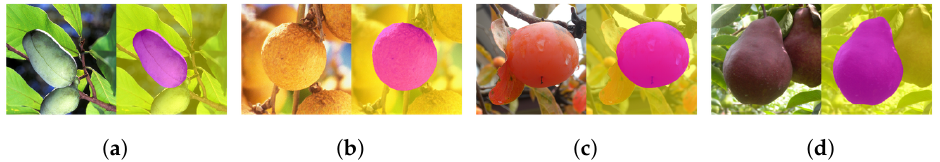
Figure 1. CROP identifies and paints central fruit of various kinds. These images were not used for the training or validation, and are considered to be test data. ( a ) pawpaw. ( b ) longan. ( c ) persimmon. ( d ) pear. The original photos of ( a , b ) are credited to USDA ARS (Scott Bauer), and those of ( c , d ) Hideki